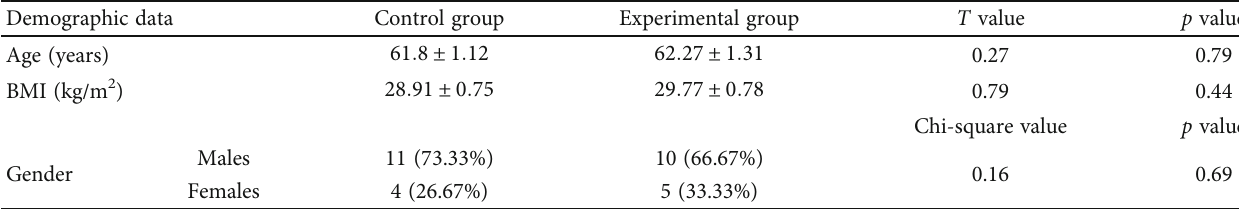
Table 1: Baseline characteristics of the subjects in both